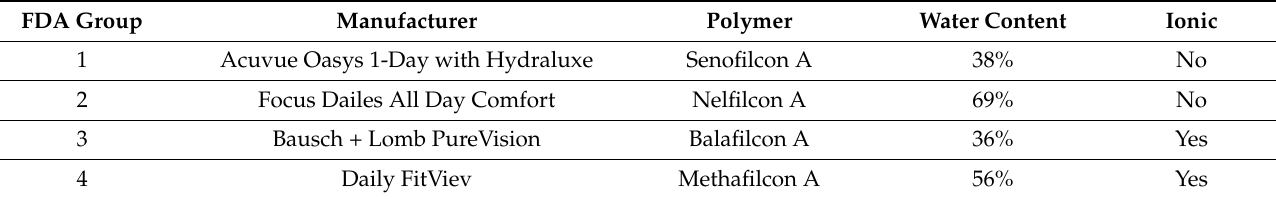
Table 2. Characterization of selected hydrogel contact lenses as per FDA classification.